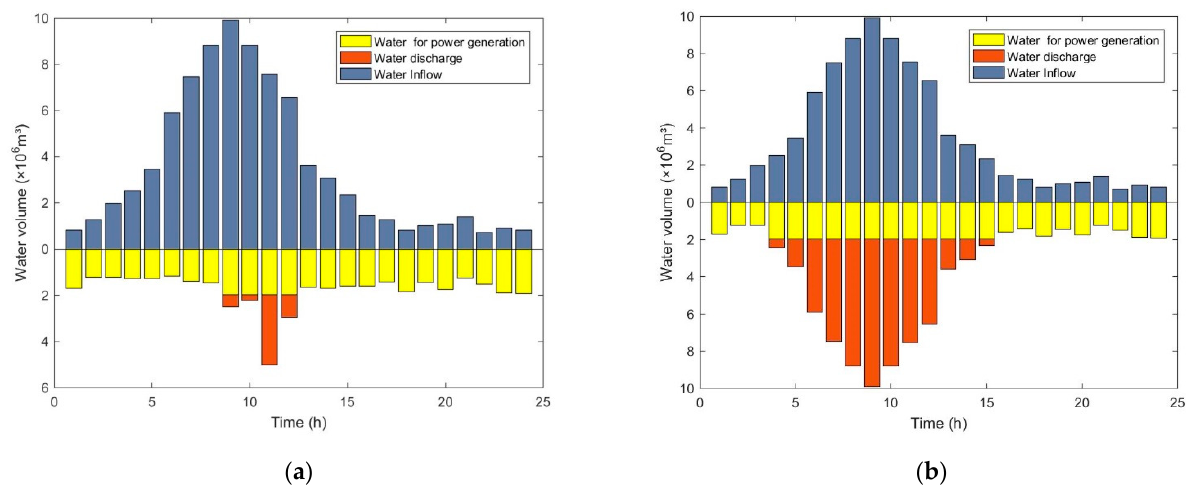
Figure 14. Comparison of water storage changes in hydropower and wind power joint dispatch schemes. ( a ) Water storage change based on the hedging theory scheme; ( b ) Water storage change of conventional schemes.